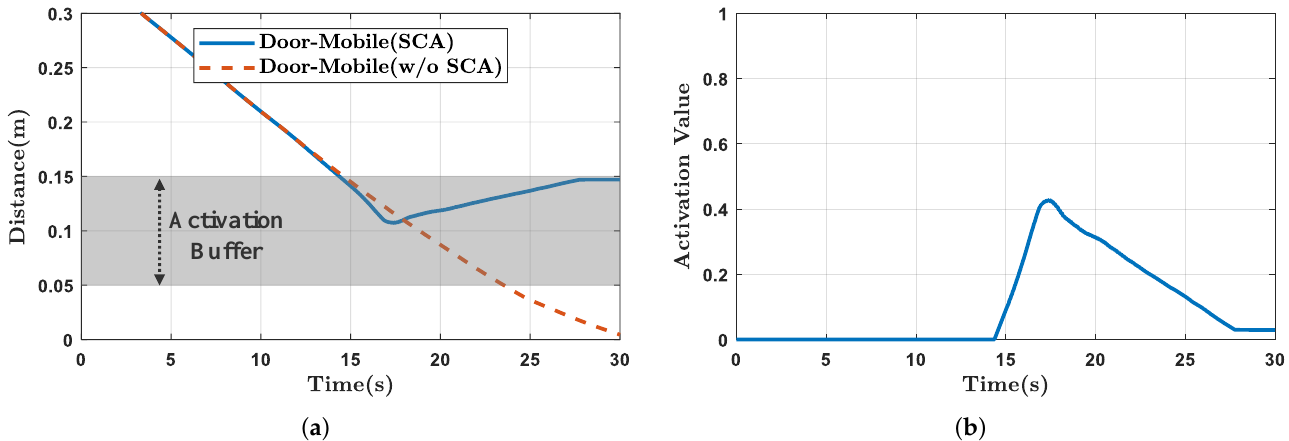
Figure 18. Simulation results of opening the refrigerator. ( a ) The distance between the door and the mobile robot; ( b ) the value of the activation